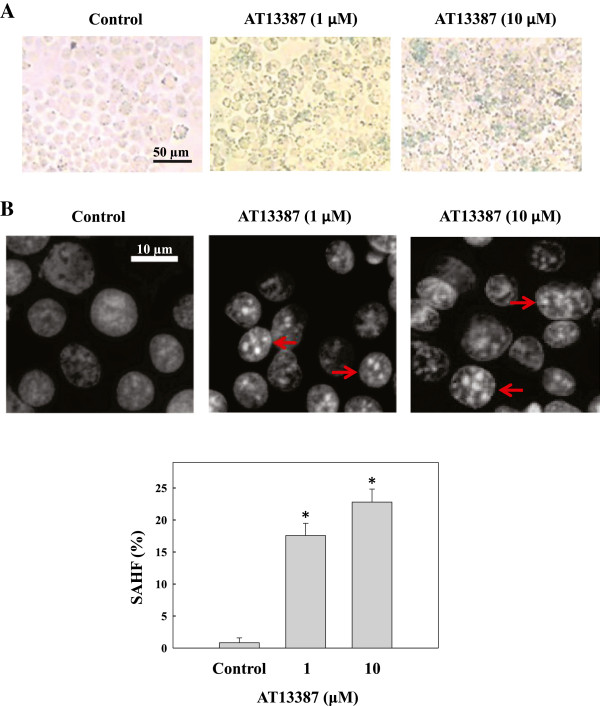
Characterization of senescence phenotypes in AT13387-treated C666-1. (A) Staining of senescence-associated β-galactosidase (SA-β-gal). Senescent cells were identified as cells stained blue after 72 hrs of AT13387 treatment. Scale bar = 50 μm. (B) DAPI staining and quantification of senescence-associated heterochromatic foci (SAHF). Upper panel: microscopic image showing formation of SAHF in C666-1 cells with AT13387 treatment for 96 hrs. Scale bar = 10 μm, red arrow indicated cells with typical SAHF. Lower panel: bar chart showing the percentage of cells with SAHF. At least 200 cells were counted from different microscopic fields for each treatment. Results were expressed as the mean ± S.D. of three independent experiments; *p < 0.05.